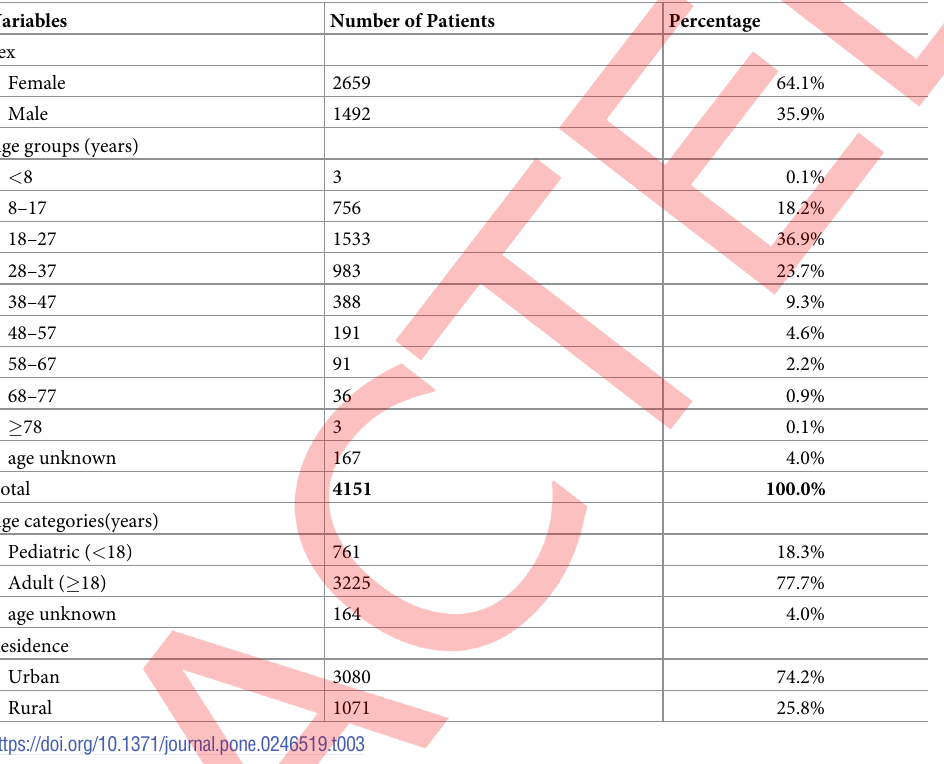
Table 3. Socio-demographic characteristics of study participants with a hospital diagnosis of ARF/RHD, 2015– 2018,